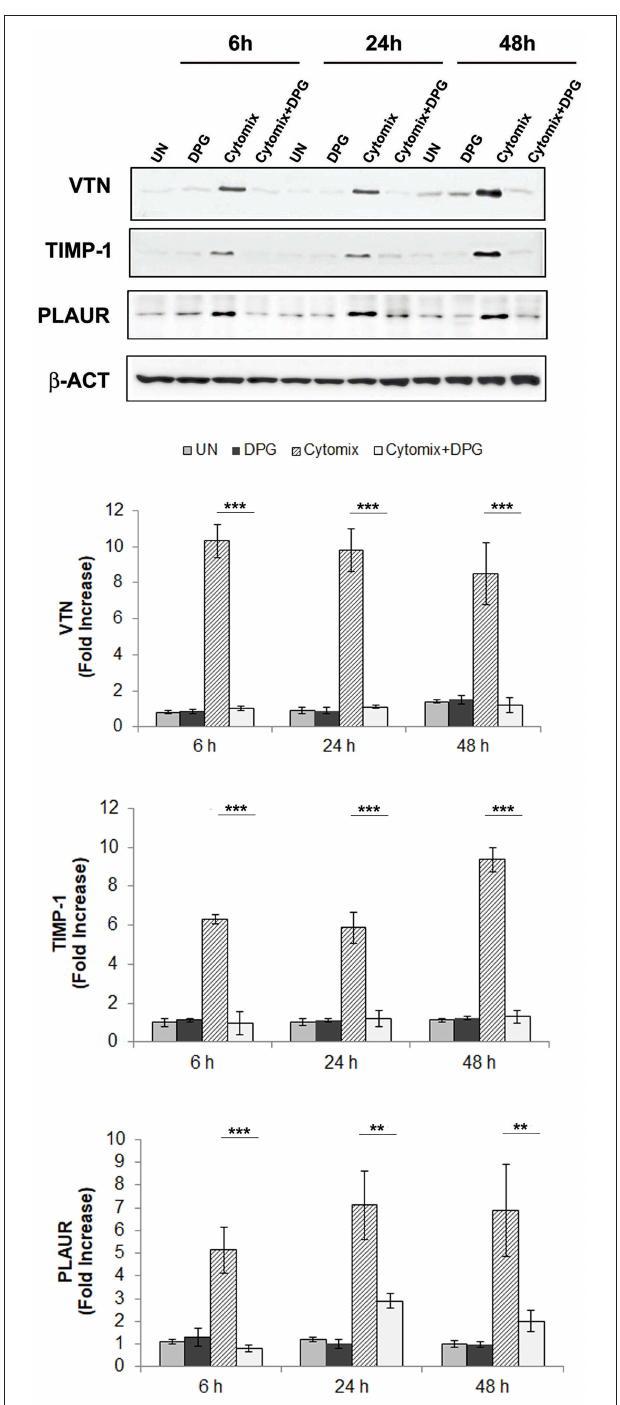
FIGURE 2 | DPG reduced in vitro the expression of wound healing genes: VTN, TIMP-1, and PLAUR altered by inflammatory stimulus. HT-29 cells were exposed to cytomix or co-exposing to cytomix + DPG and protein expression of VTN, TIMP1, and PLAUR were analyzed by western blot. Bar chart represented fold increase (Densitometric Unit) vs. UN. The experiment was performed in triplicate and repeated 3 times. Statistical analysis: Mann-Whitney test, the comparison between Cytomix vs. Cytomix + DPG was reported. ** p < 0.01, *** p < 0.001. UN, untreated cells; DPG, dipotassium